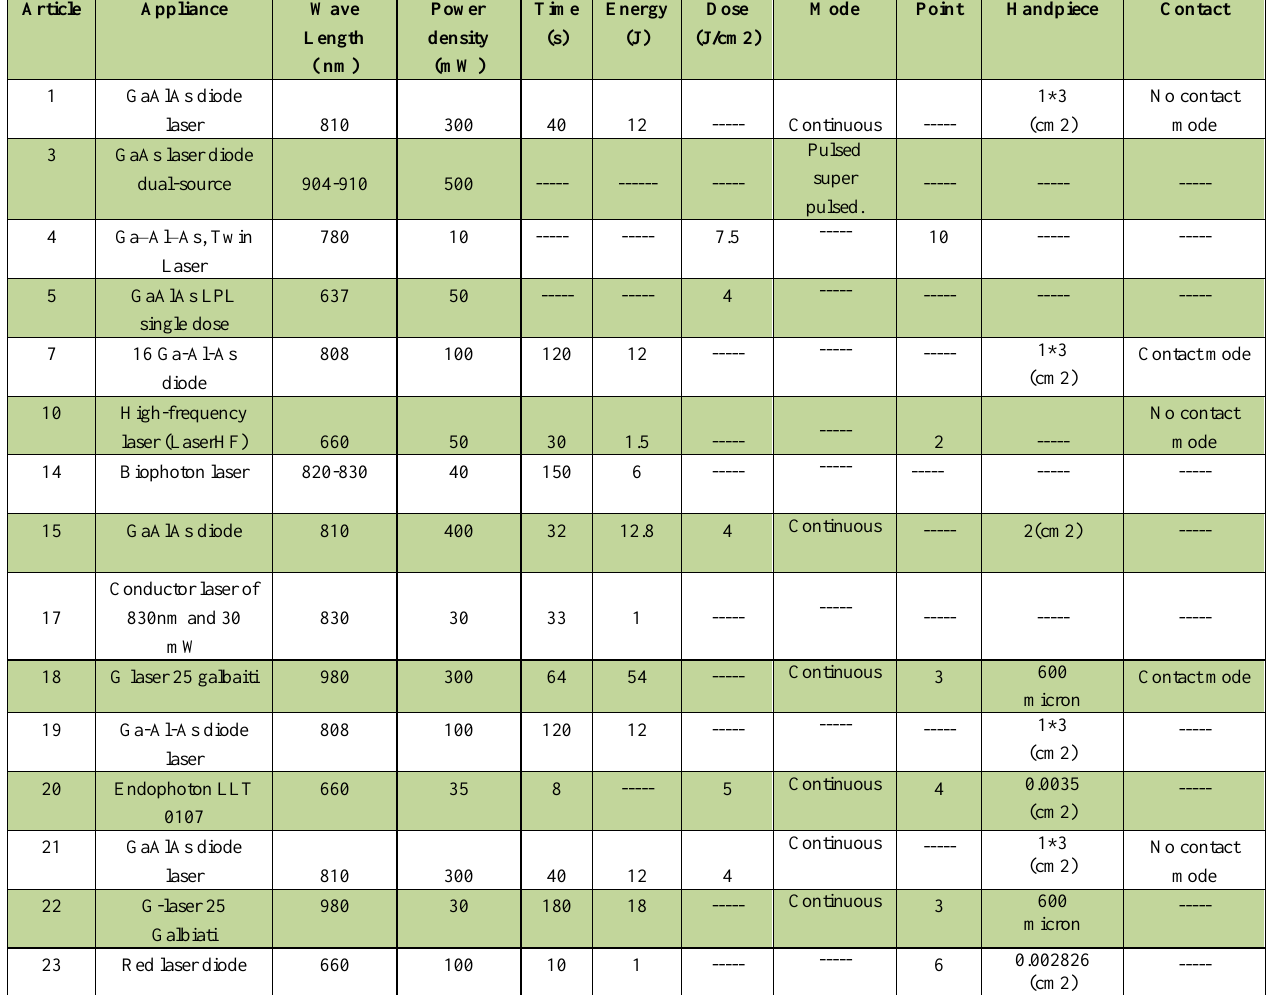
Table 2: Characteristics Of Laser Appliance.